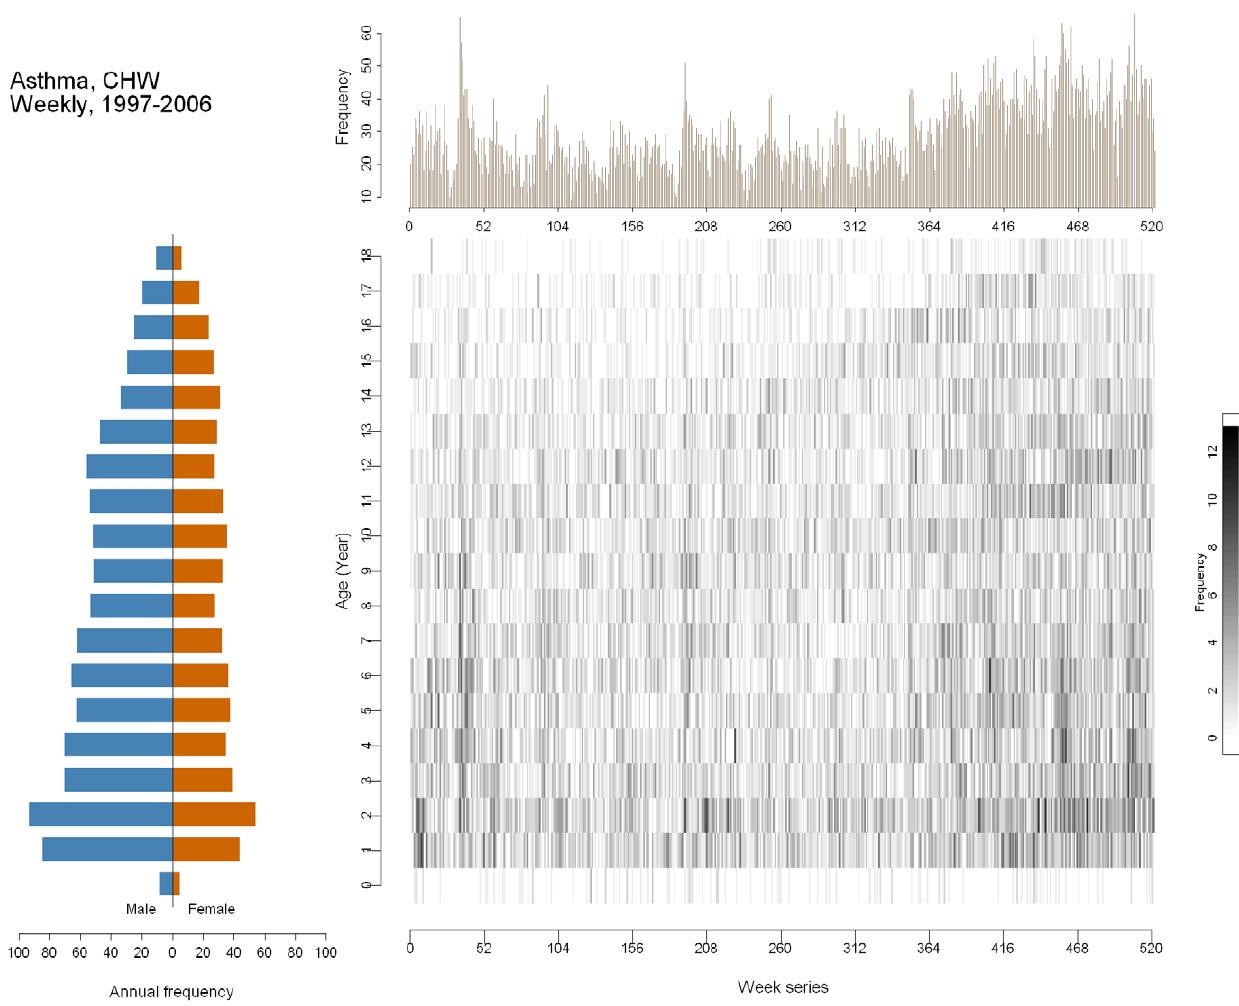
Figure 5. Multi-panel graph of asthma in children aged 0–18 in Milwaukee 1997–2006. Lower left: outcome pyramid; upper right: time- series plot; lower right: image plot.